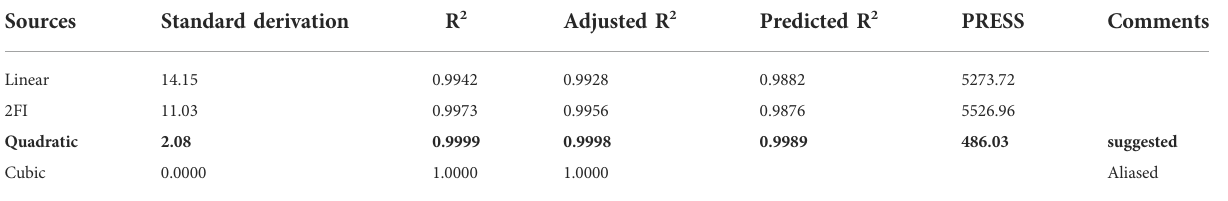
TABLE 3 Model summary statics Entropy generation number.